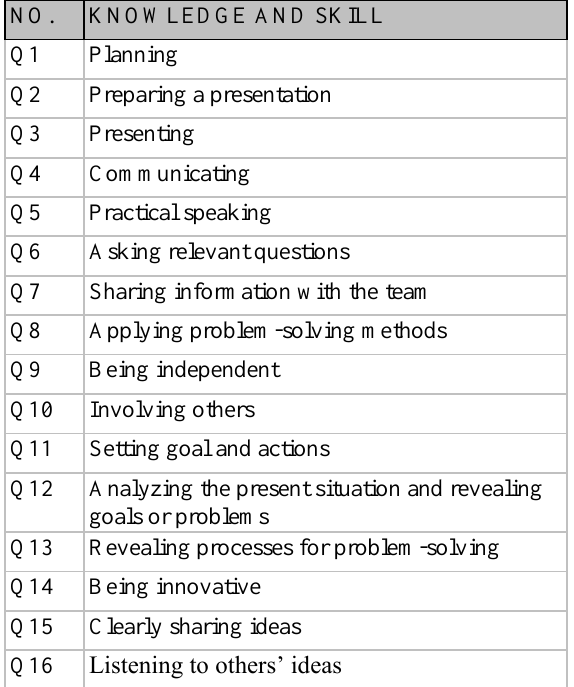
Table 1. Questionnaire items: Q1–Q19 are common to all courses while Q20-Q28 are specific to the system development course to measure team knowledge and